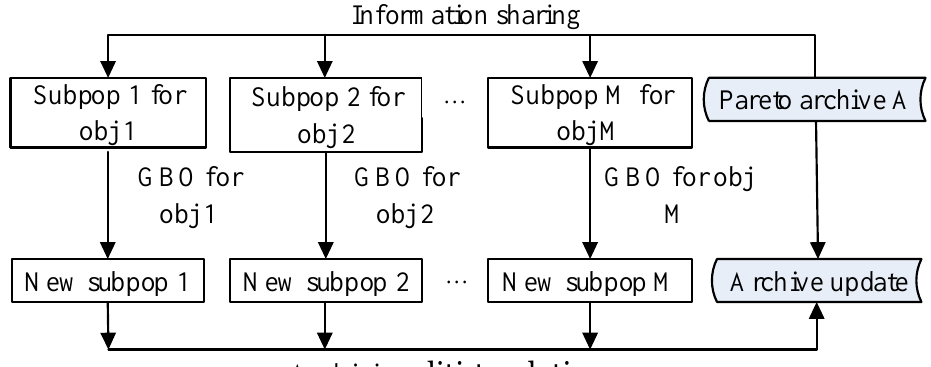
Figure 2. The framework of CMGBO.